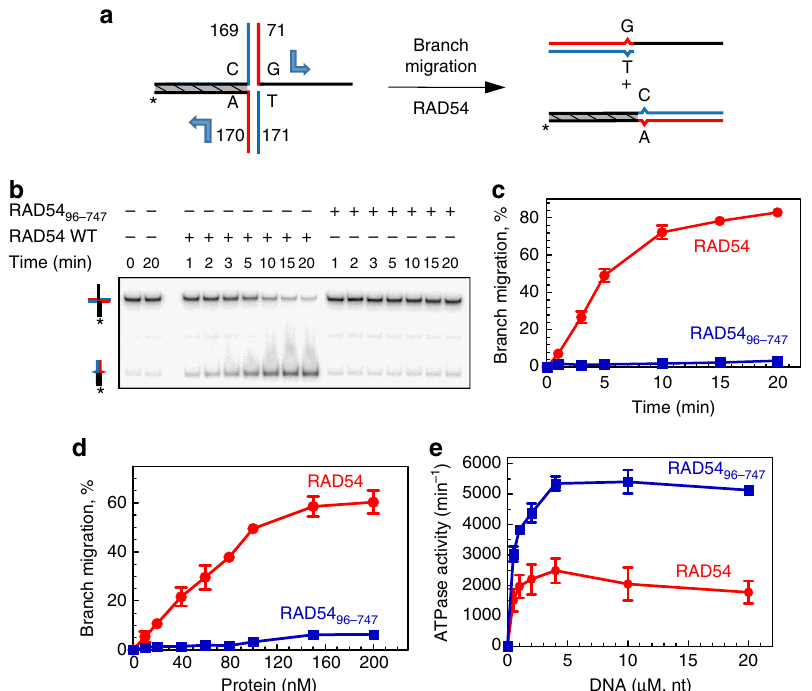
Fig. 2 The RAD54 NTD is essential for BM, but not for ATP hydrolysis. a The experimental scheme of the BM reaction. Shown is one bp heterology that was introduced into the PX junction (no. 71/169/170/171) to reduce the spontaneous BM. The shaded region denotes the heterologous DNA branch. The direction of BM is denoted by blue arrows. The asterisk indicates the 32 P-label. The numbers correspond to oligonucleotides in Supplementary Table 1. b The kinetics of BM of PX junction (10 nM, molecules) promoted by RAD54 (30 nM) or RAD54 96 – 747 (30 nM). The BM products were analyzed by electrophoresis in 8% polyacrylamide gels. c Data from b are plotted as a graph. d The effect of RAD54 or RAD54 96 – 747 concentrations on DNA BM. The reaction was carried out for 90 s. e ATP hydrolysis by RAD54 (20 nM) and RAD54 96 – 747 (20 nM) using supercoiled pUC19 as DNA substrate. Each experiment was repeated three times. Error bars represent the standard error of the mean (s.e.m.)